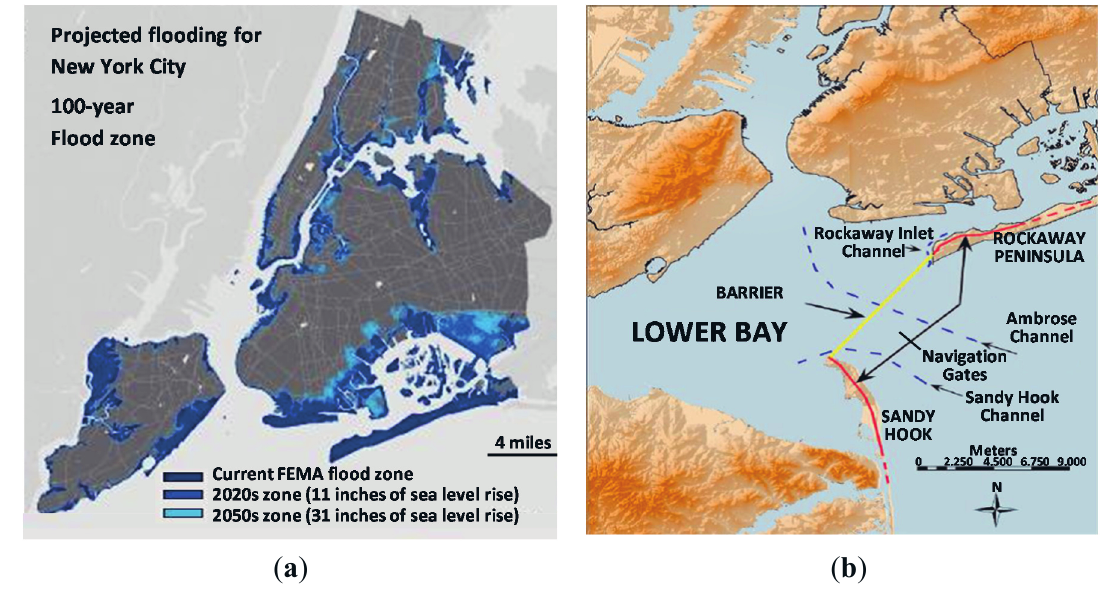
Figure 11. ( a ) NYC projected flooded areas for 100-year storm, SLR 79 cm by 2050 [23]. ( b ) Proposed surge barriers [24] and surge barrier with gates